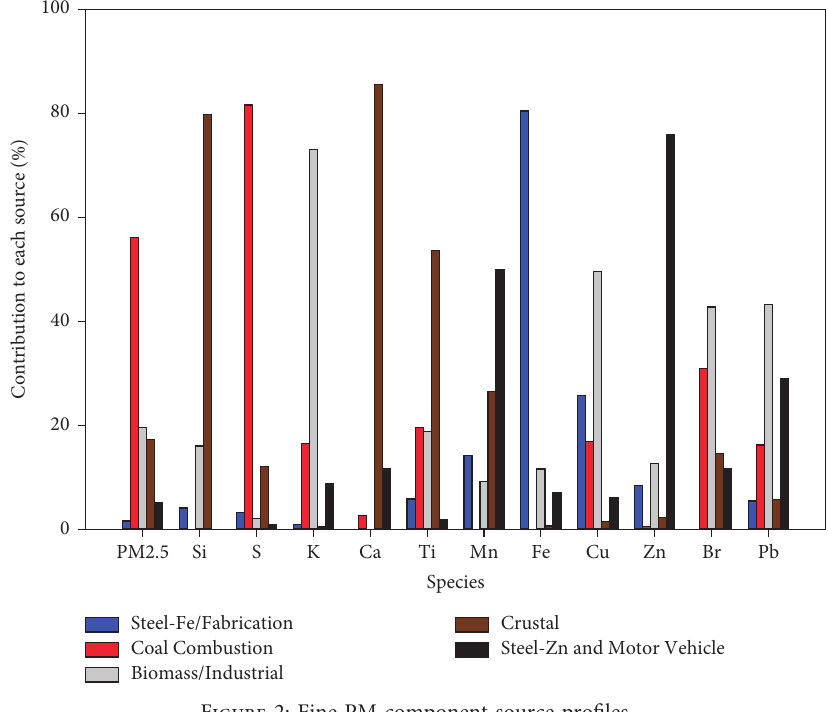
Figure 2: Fine PM component source profiles.